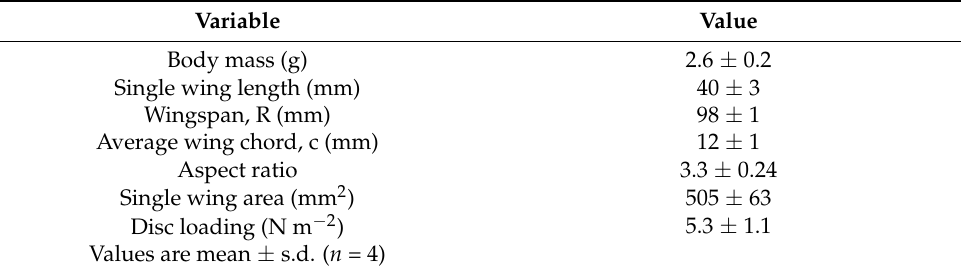
Table 1. Morphological data for calliope hummingbirds ( Stellula calliope ; n =